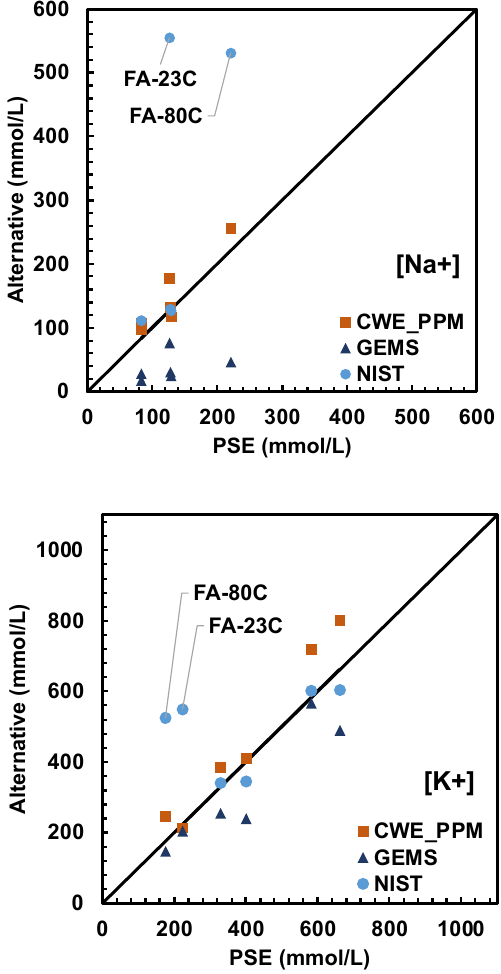
Figure 5. Comparison of alternatives to PSE for a) [Na + ], and b) [K + ]. CWE results had less than 5% coefficient of variation between trials on